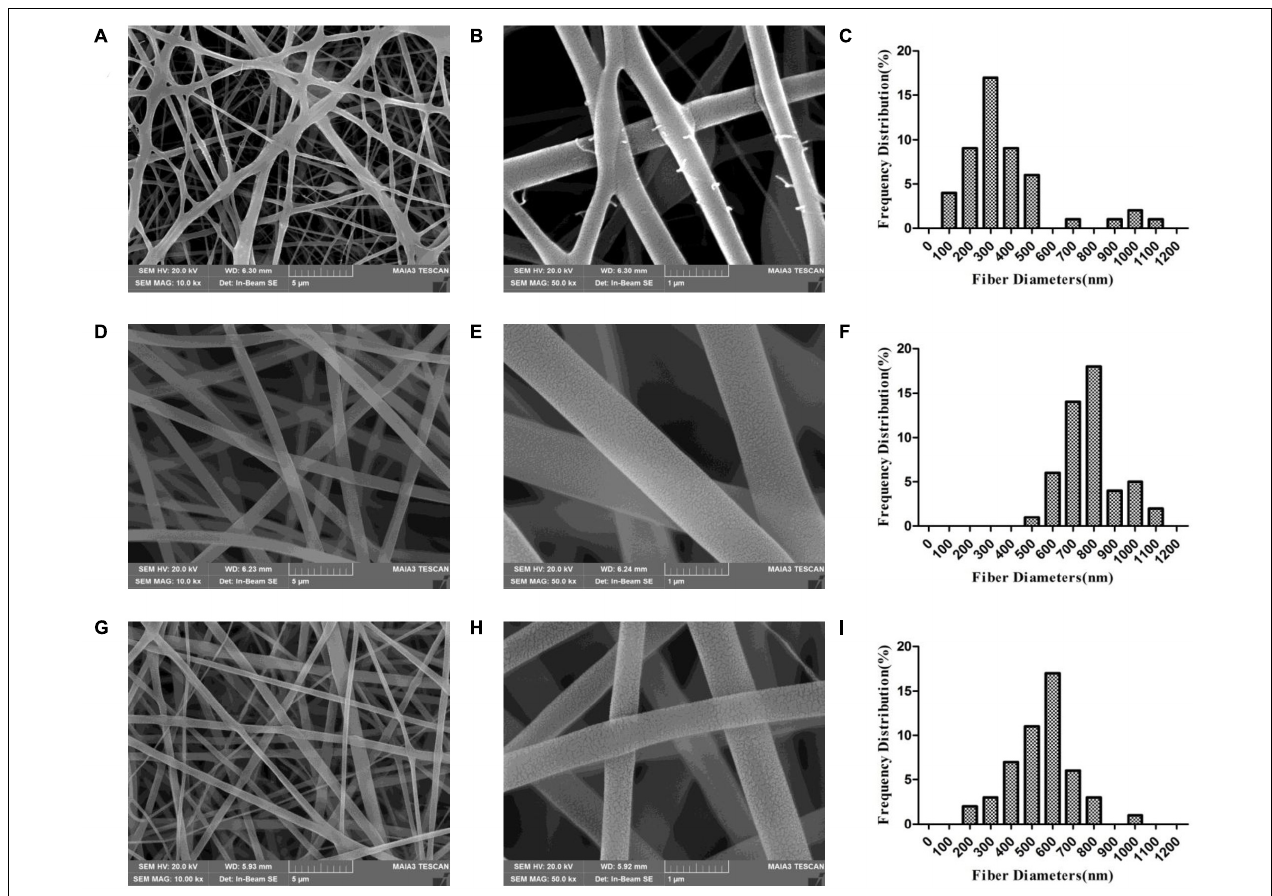
FIGURE 2 | (A–I) Scanning electron micrographs of PP-21G (A,B) , PP-20G (D,E) , and PP-BER-20G (G,H) scaffolds at low (A,D,G) , high (B,E,H) magnification, and distribution of nanofiber diameters (C,F,I)